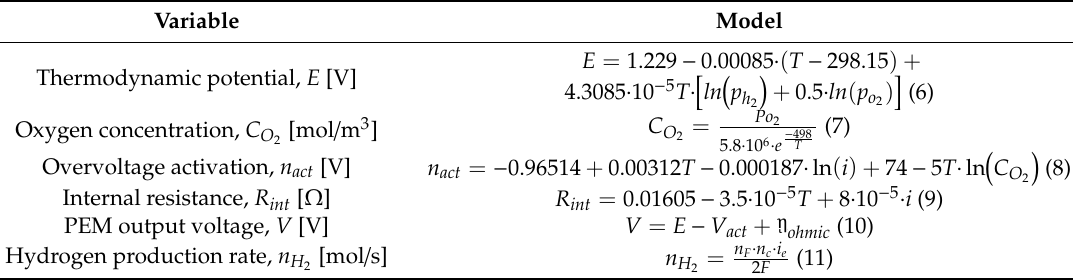
Figure 3. Wind turbine transient response curve. Table 2. Proton exchange membrane (PEM) fuel cell model.